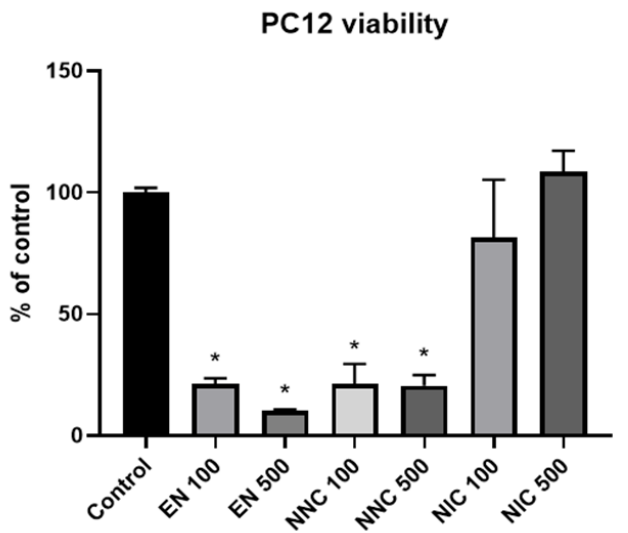
Figure 7. Viability of PC12 cells one day after various treatments with nanocapsules. EN 100 = empty nanocapsules (group 2); EN 500 = empty nanocapsules (group 3); NNC 100 = nicotine containing nanocapsules 100 μM (group 4); NNC 500 = nicotine containing nanocapsules 500 μM (group 5); NIC 100 = 100μM of bulk nicotine (group 6); NIC 500 = 500 μM of bulk nicotine (group 7); (* : p < 0.05 samples vs. control), n = 3.